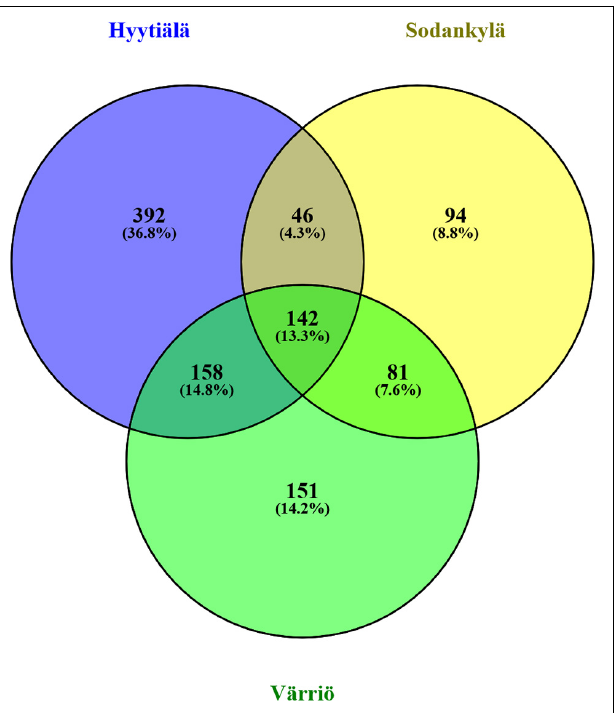
FIGURE 3 | Venn diagram showing the unique and shared OTUs in the three locations between Hyytiälä (southern), Sodankylä (northern), and Värriö (subarctic) boreal pine forests. The number of total OTUs obtained from the three locations was